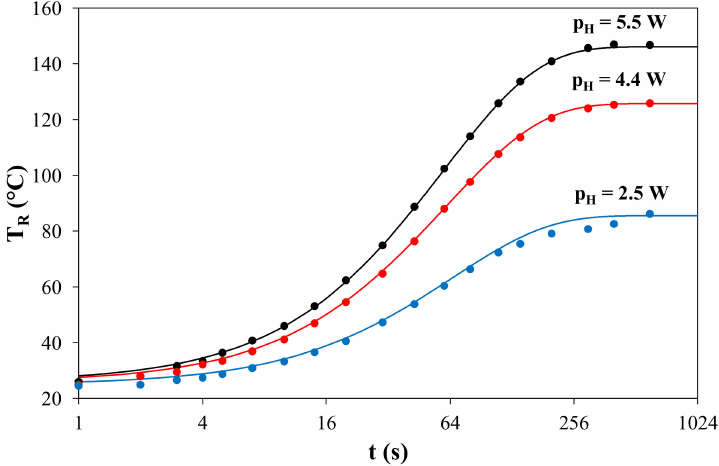
Figure 16. Measured and computed waveforms of the temperature of the resistor operating in cooling system A at selected values of the power dissipated in the resistor (system A).